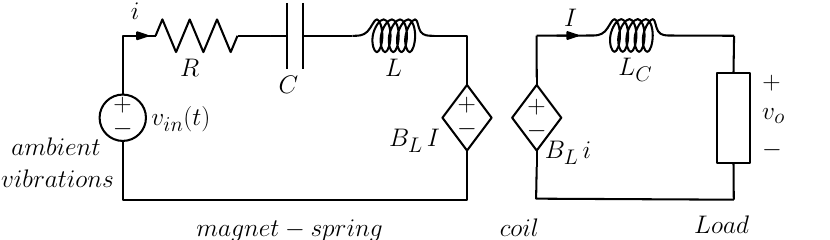
Figure 5. Equivalent circuit for an electromagnetic energy harvester. The generator v in ( t ) in the circuit corresponds to the external force f m ( t )